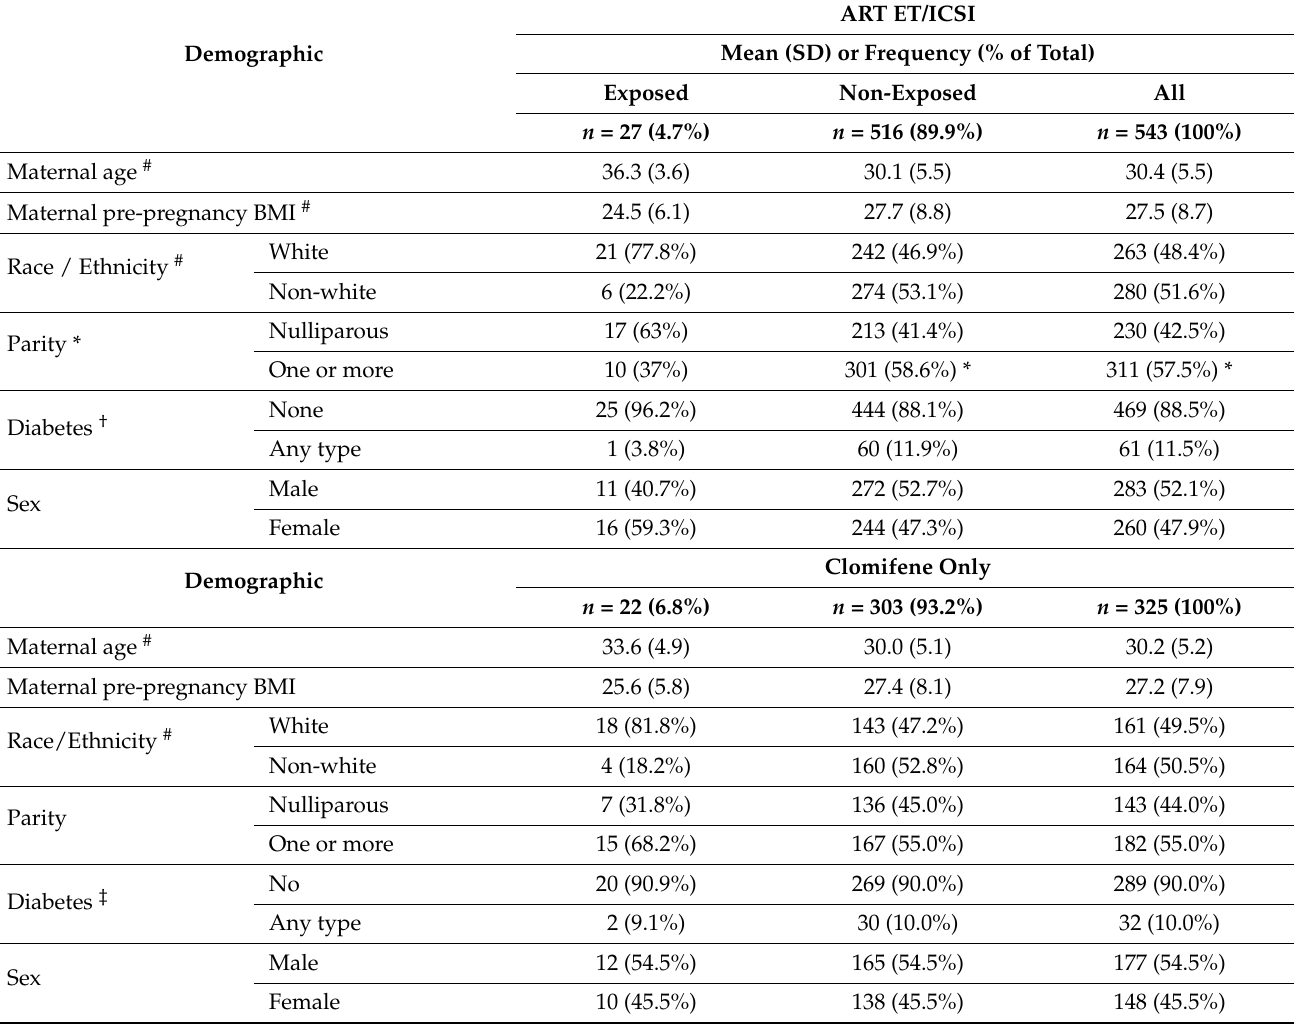
Table 1. Participant